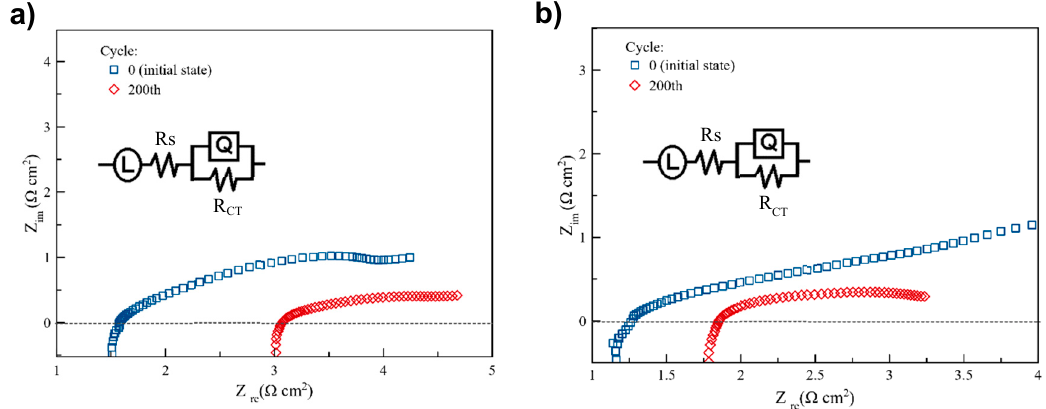
Figure 11. Nyquist plots of cycling impact on cell impedance when using ( a ) Zn / IF and ( b ) Zn / NF electrodes at the initial state (t = 0) and after the 200th charge–discharge cycle at a frequency range from 100 kHz to 0.1 Hz with an alternate current amplitude of 10 mV around OCV. Table 3. Resistance values of Zn anodes in the electrolyte at initial state (t = 0) and after the 200th charge–discharge cycle.